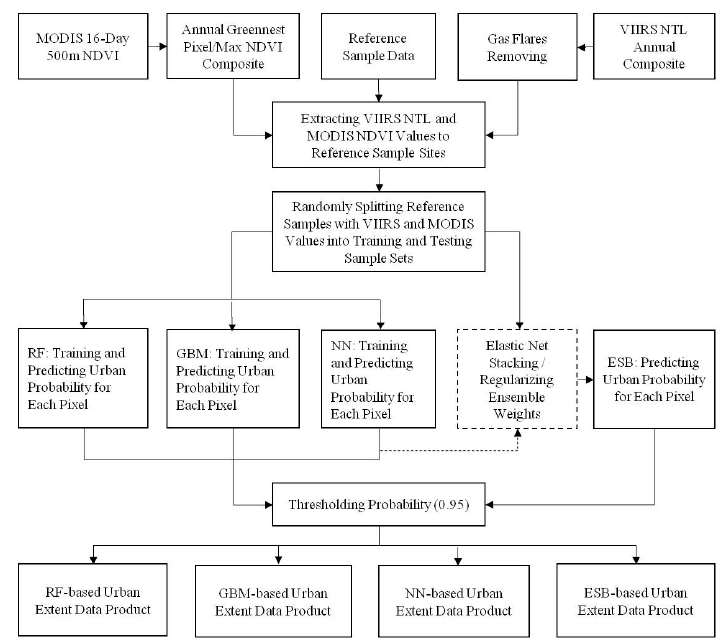
Figure 5. The workflow for data processing and machine learning prediction of urban extent.